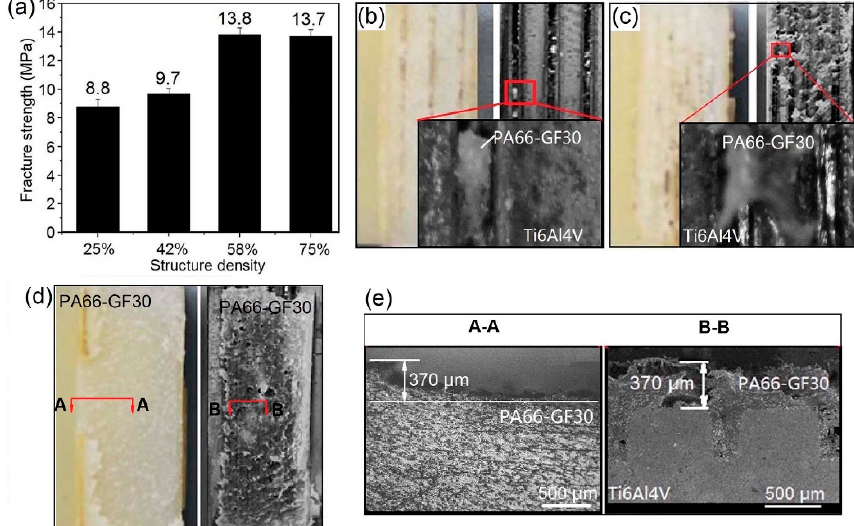
Figure 4. ( a ) Fracture strength of LAMP produced Ti6Al4V-PA66-GF30 joints with various structure densities on Ti6Al4V surfaces; ( b )–( d ) surface morphologies and cross-section morphologies of LAMP produced Ti6Al4V-PA66-GF30 joints with structure density of 25% ( b ), 42% ( c ), and 58% ( d ), respectively; ( e ) cross-sections of the Ti6Al4V and PA66-GF30 parts of the failed Ti6Al4V-PA66-GF30 joint in ( d ).